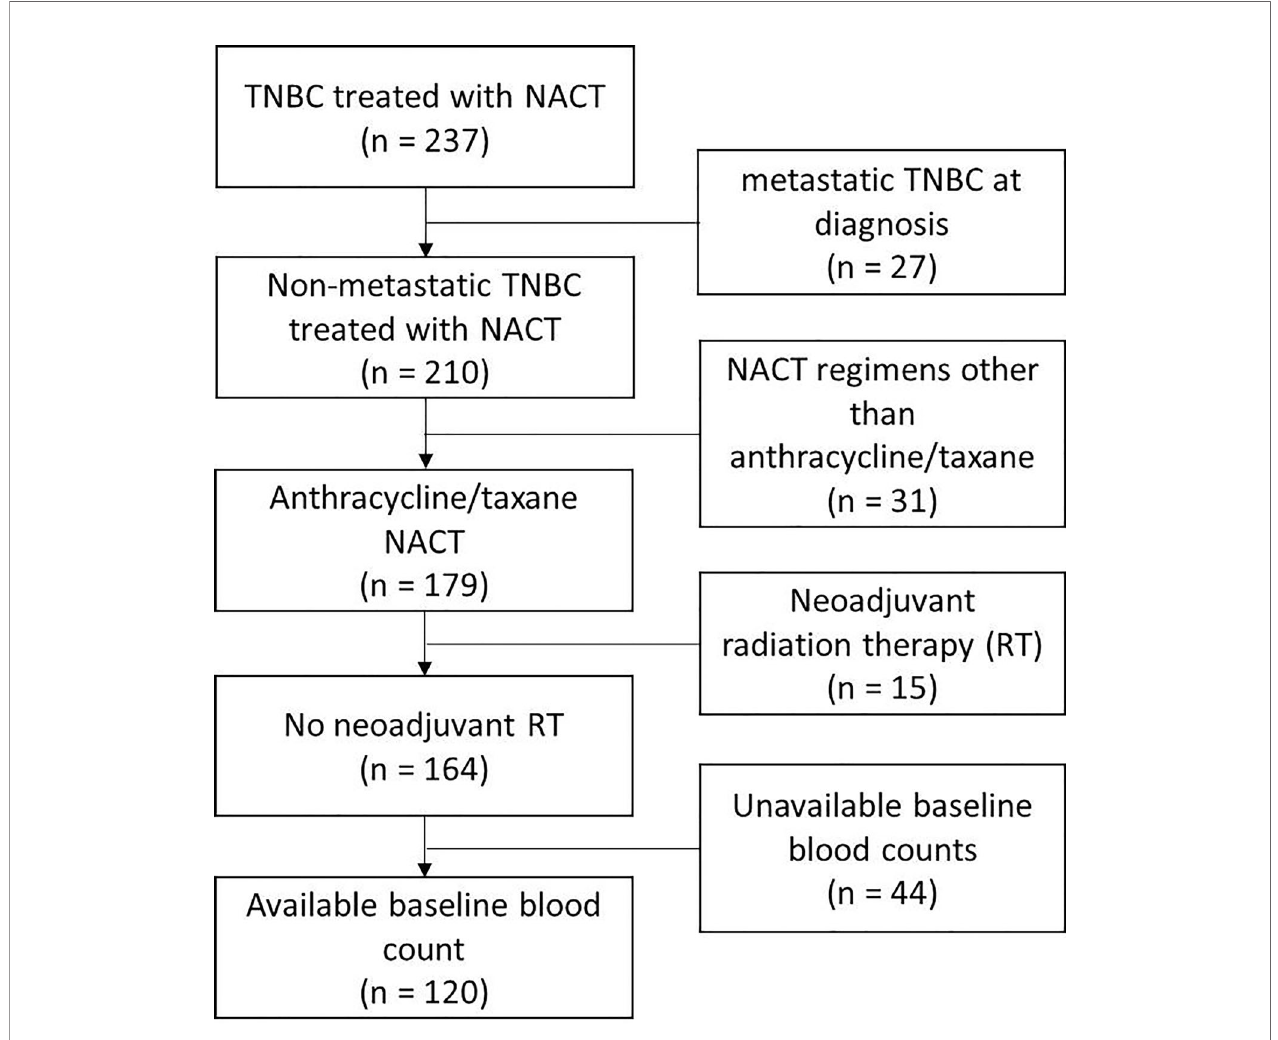
FIGURE 1 | Patient selection fl